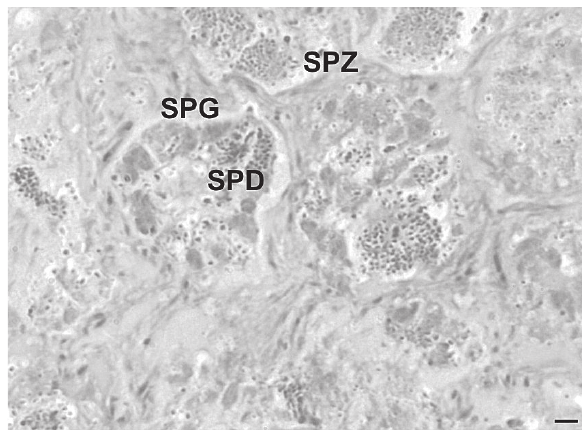
Fig . 3. – Gaidropsaurus granti testis section showing a weak, re- sidual spermatogenesis activity. Spermatogonia (SPG), spermatids (SPD) and few spermatozoa (SPZ) are visible. Bar=50 μm.